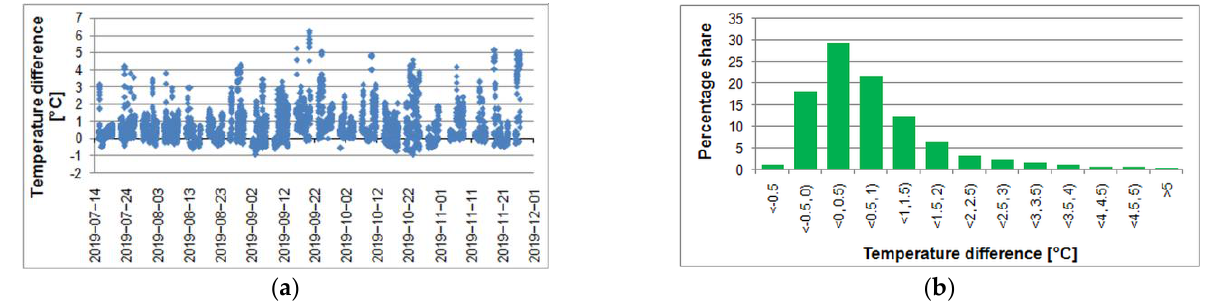
Figure 16. ( a ) Difference between temperatures T9 and T0; ( b ) percentage share of T9-T0 differences.